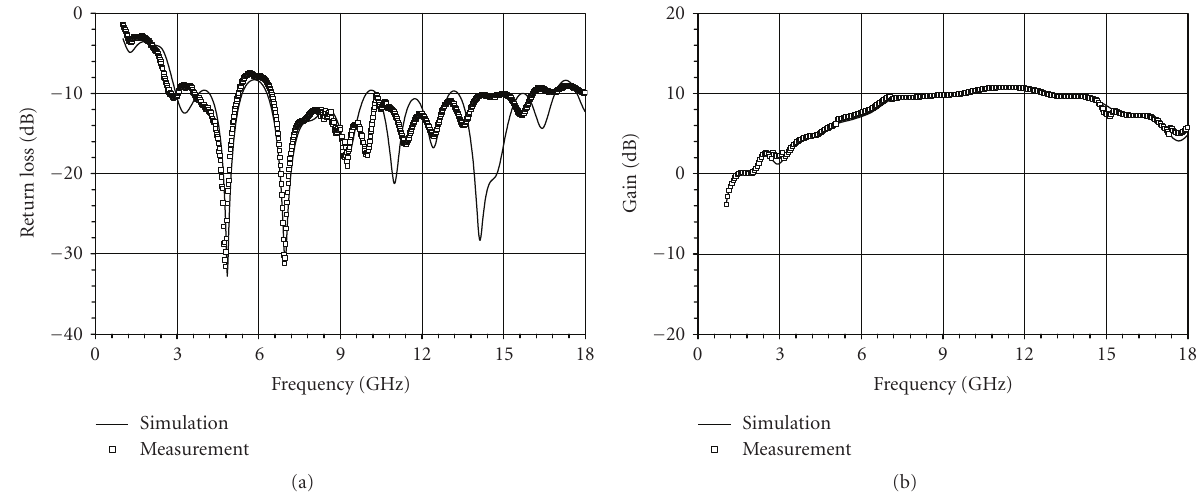
Figure 2: Comparison of simulated and measured return loss and gain of the reference DETASA shown in Figure 1; (a) return loss, (b) gain.